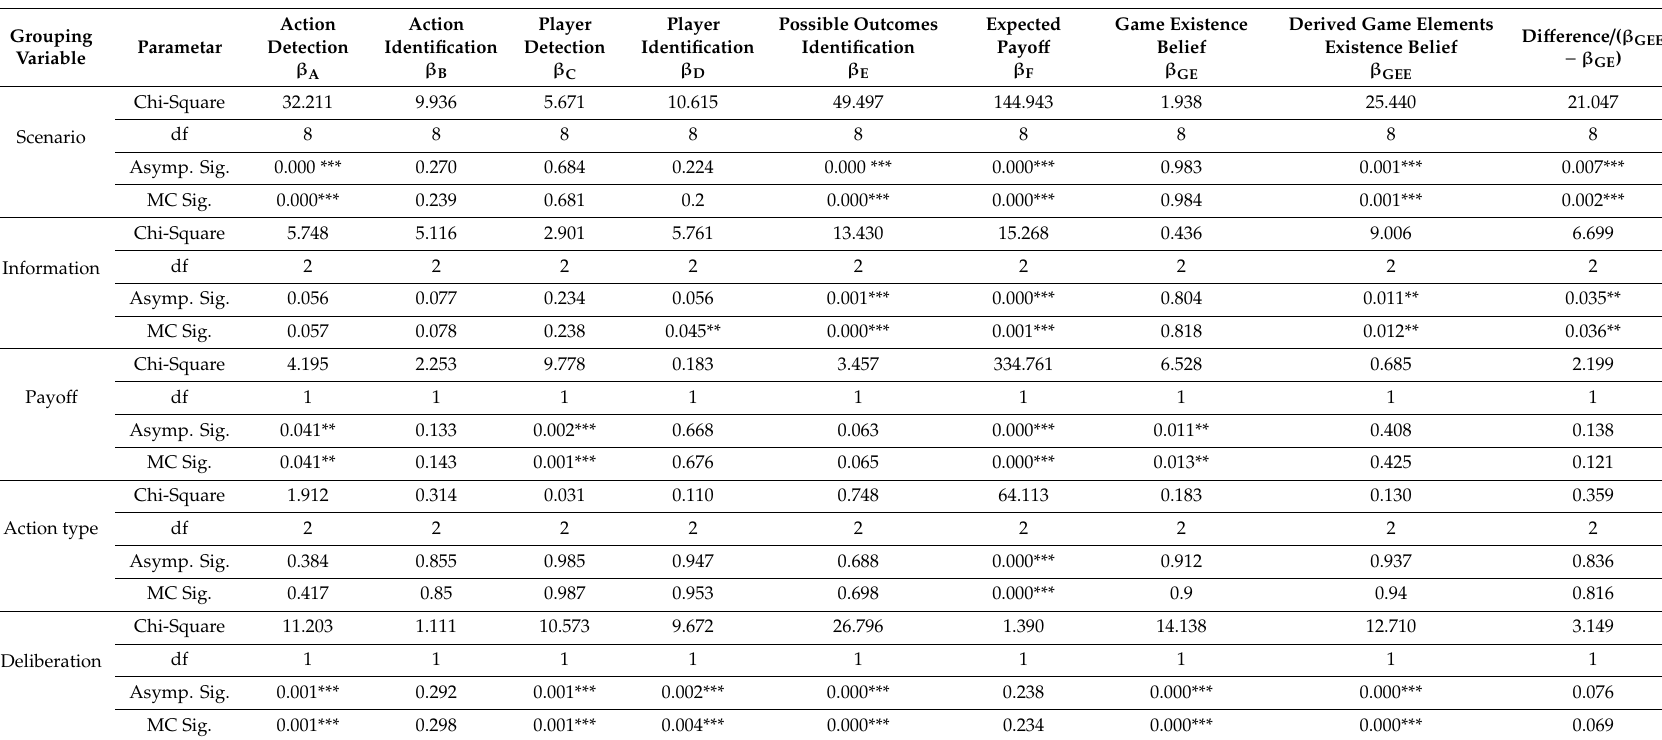
Table 5. Di ff erences between game elements’ existence estimates given the scenario, provided information, payo ff , action type, and